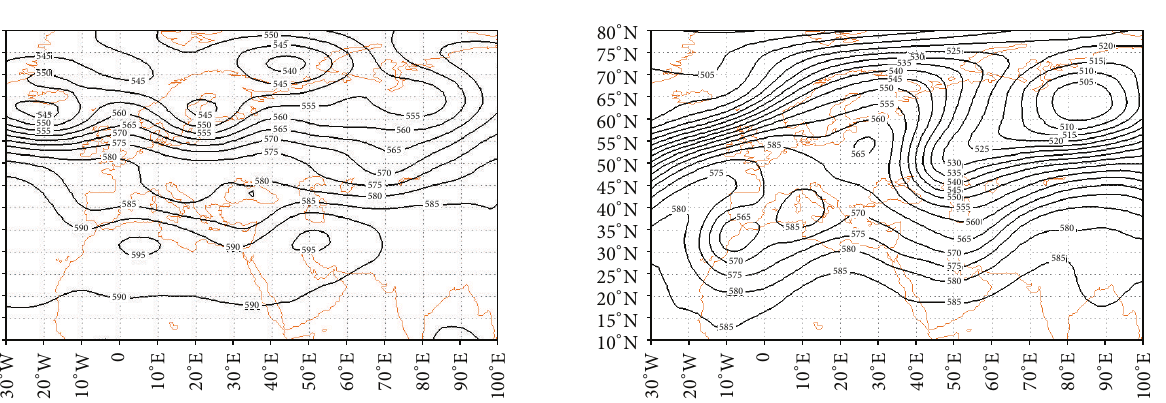
Figure 30: Geopotential elevation map at level 500 HPa in the representative day of pattern C.